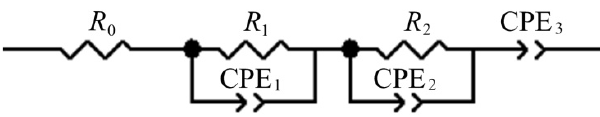
Figure 9. Equivalent circuit used for the impedance hodograph fitting. Table 1. Impedance fitting data as a function of voltage.